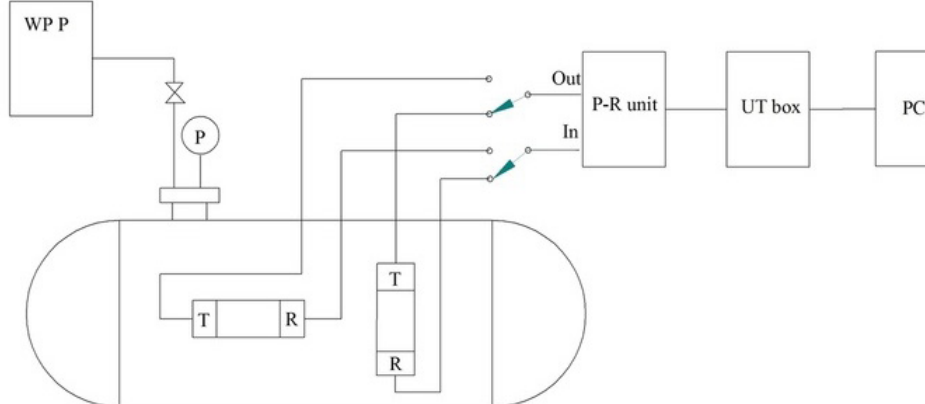
Figure 2. Experimental